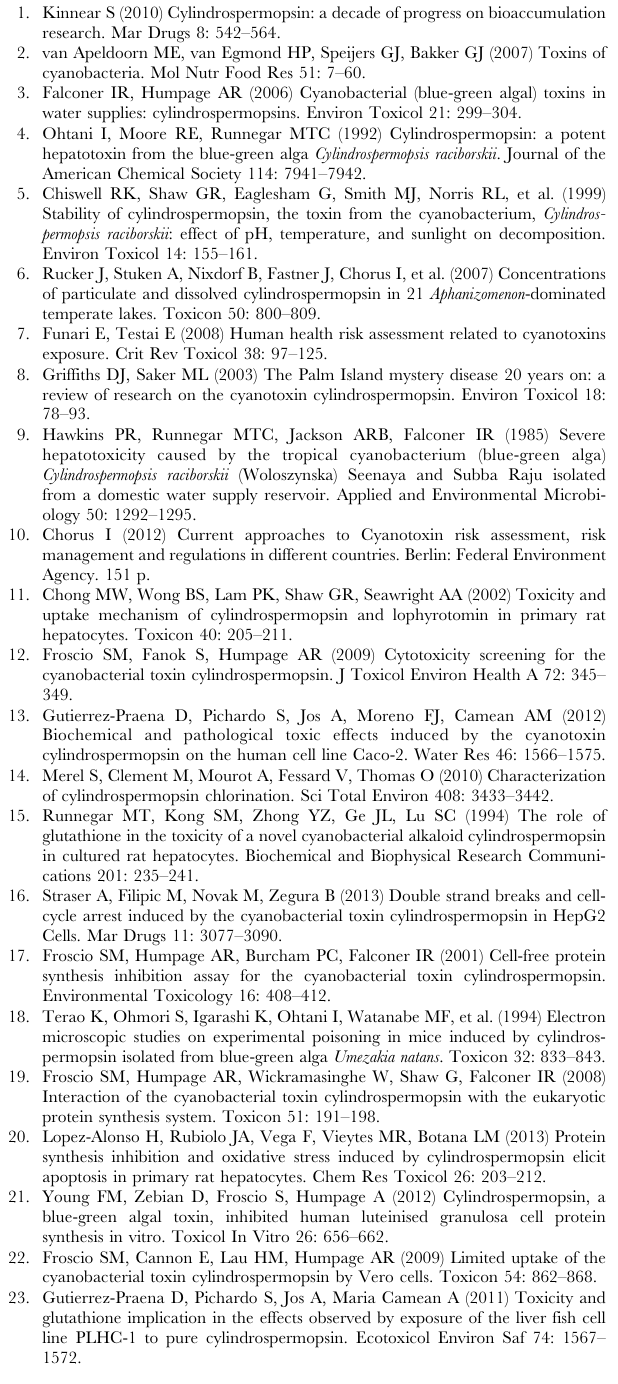
Table S3 Cellular components and molecular functions for up-regulated genes in differentiated Caco-2 cells after 24 hrs exposure to 1.6 m M CYN. Table S4 Categories and biological functions for differ- entially regulated genes in differentiated Caco-2 cells after 24 hrs exposure to 1.6 m M